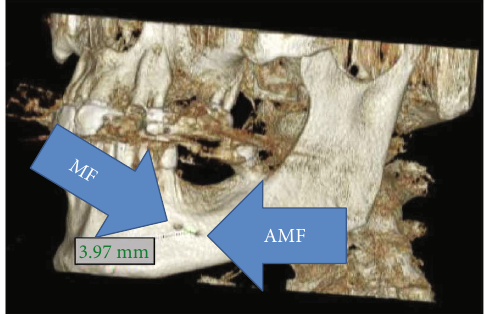
Figure 4: Left AMF at reconstructed CBCT.